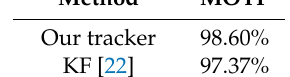
Table 2. Evaluation metrics for a person tracking based on the sequence of images.